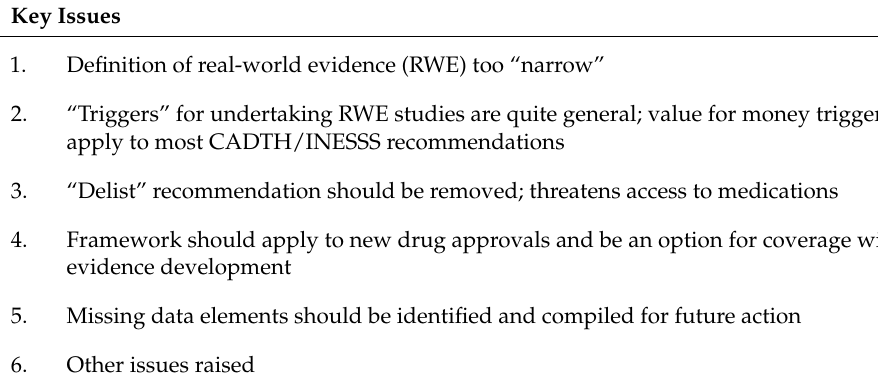
Table 1. Key Issues Discussed by Patient